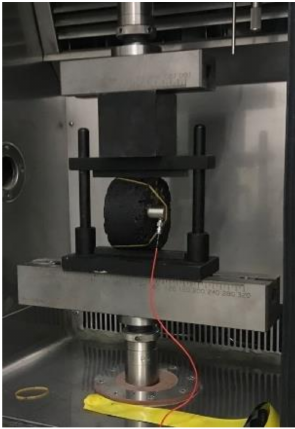
Figure 2. The indirect tensile test of